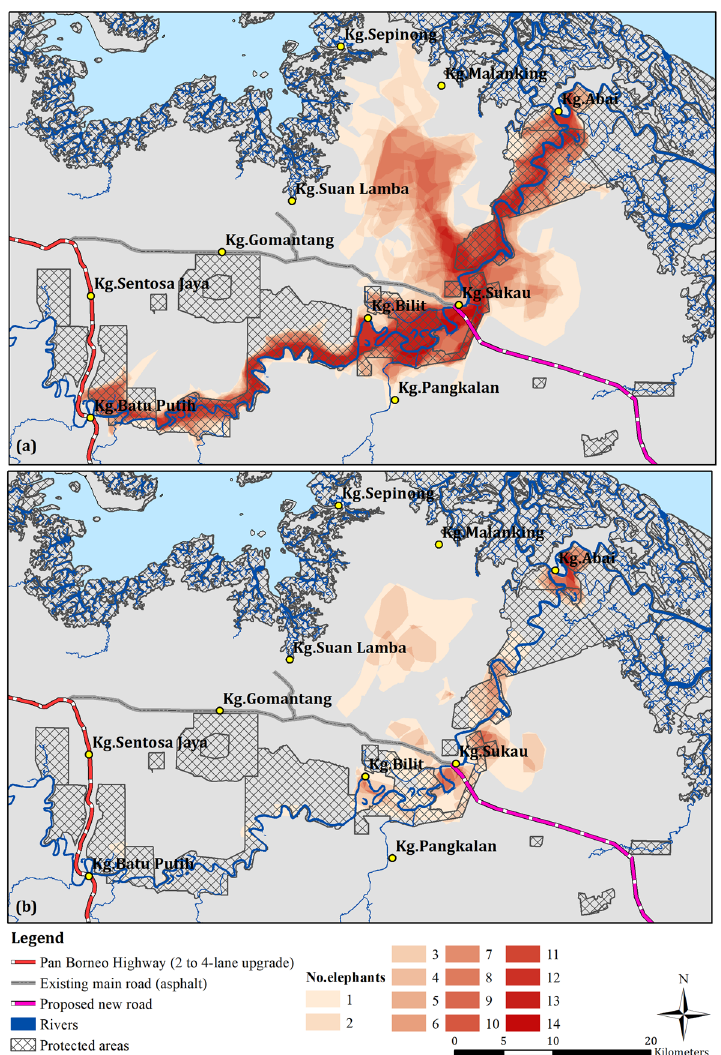
Figure 2. Heat maps showing the cumulative areas of elephant ranges for their entire range ( a ) and hot spot areas ( b ) along with information on the planned 4-lane Pan Borneo Highway from the current existing 2-lane road (red), other planned new road (pink) and the current existing road (grey), along with Protected Areas/ Forest Reserves (black cross